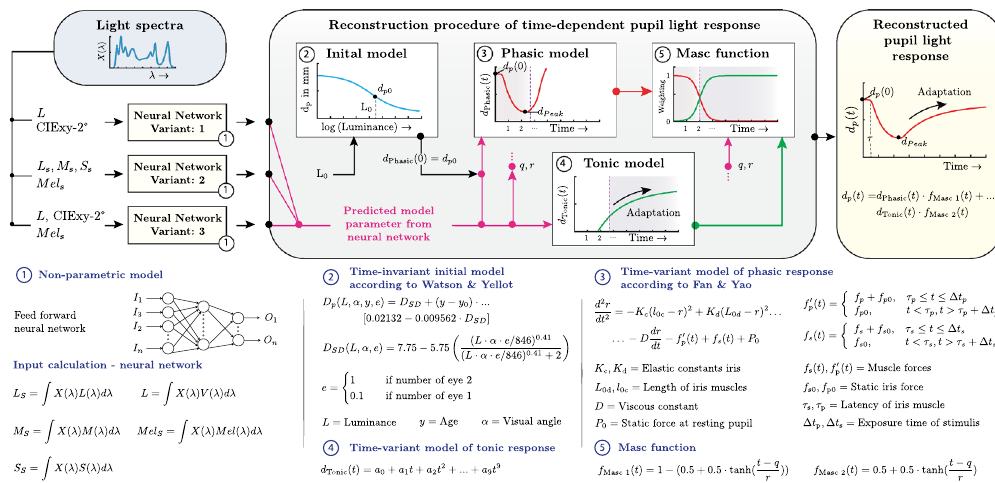
Figure 3. Structure of the proposed overall model for reconstructing the temporal pupil response based on neural networks. Step 1: The derived stimulus characteristics are entered into the neuronal network and the model parameters of the phasic and tonic model are predicted. Step 2: The initial pupil diameter is determined with the Watson and Yellot model from the luminance of the anchor spectrum. Step 3: The initial pupil diameter and the predicted model parameters from the neural network are used to determine the numerical solution of the phasic model, which is based on the Fan and Yao differential equation. Step 4: The second part of the predicted model parameters from the neural network is used for the tonic model. Step 5: The results of the phasic and tonic model are combined with two masking functions to reconstruct the complete pupil light response caused by a respective photometric or receptor-based